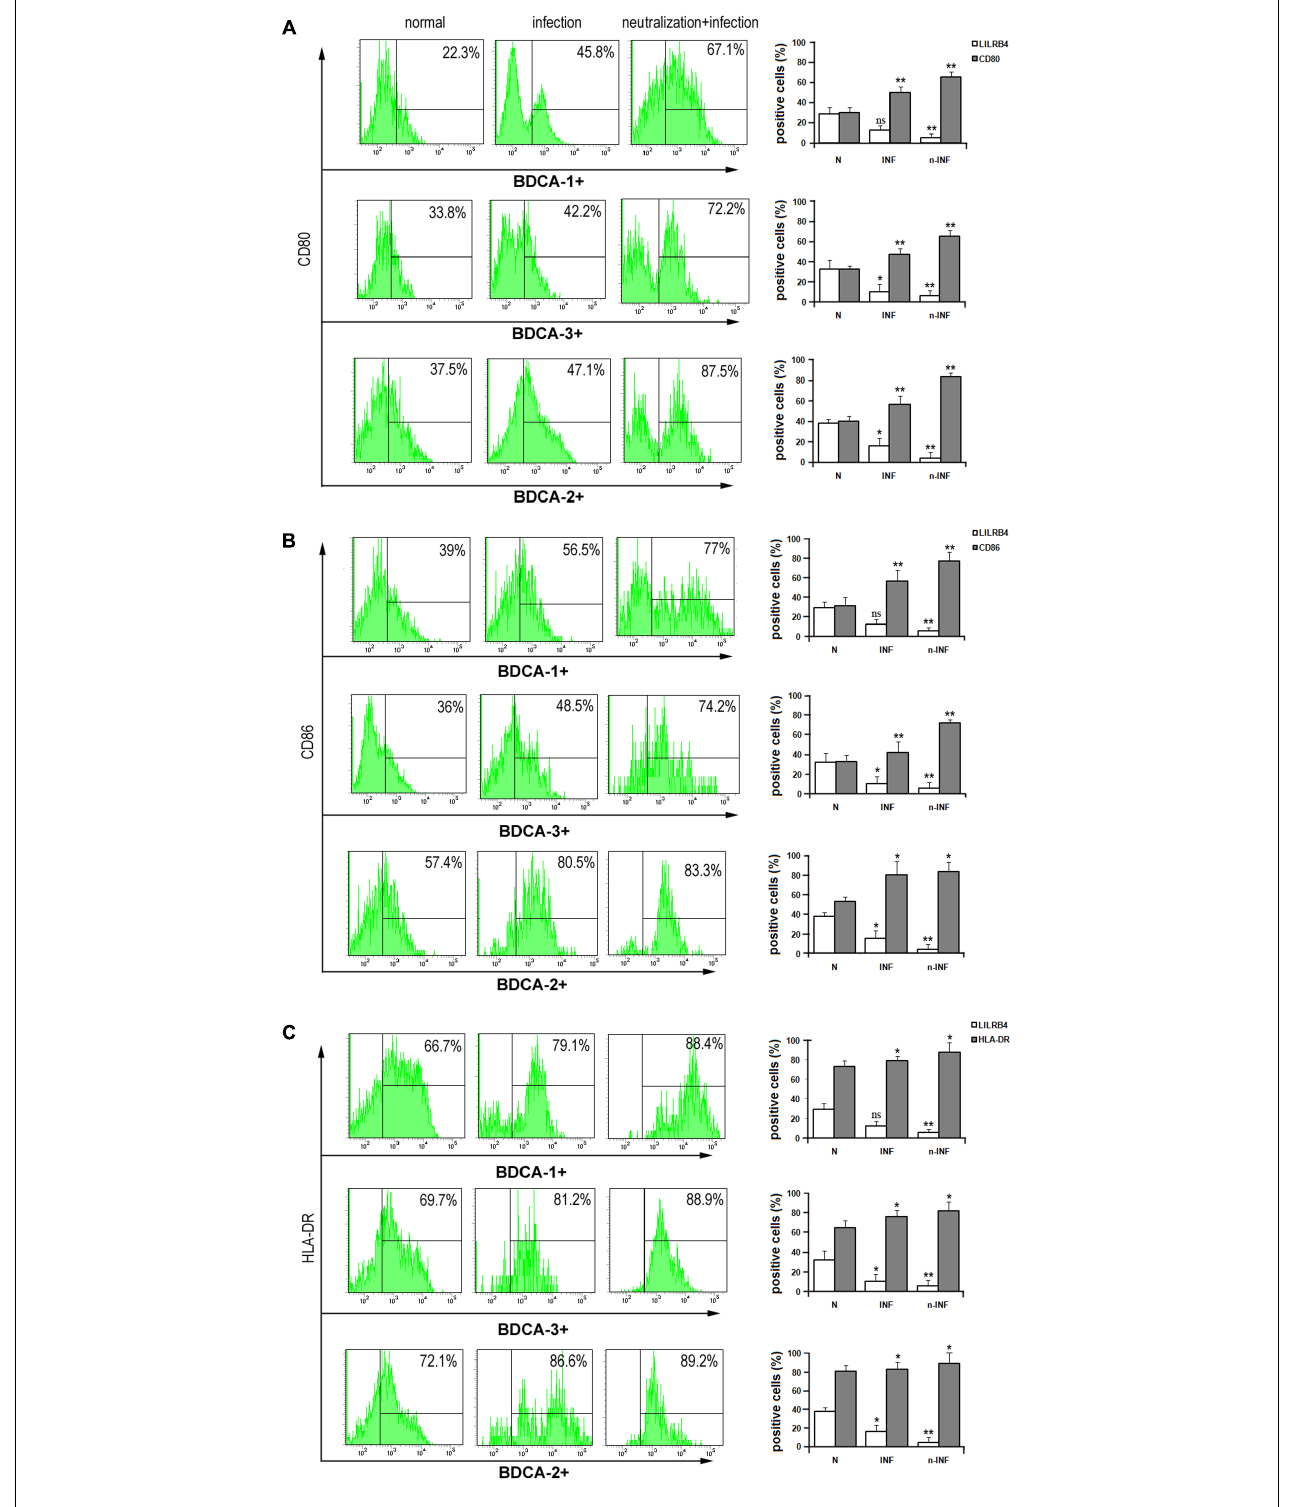
FIGURE 4 | Down-regulation of LILRB4 on human uDC subsets with T. gondii infection resulted in changes in the expression of functional molecules of human uDCs. Flow cytometry and histogram analyses of CD80 (A) , CD86 (B) , HLA-DR (C) and LILRB4 expression in BDCA-1 + , BDCA-2 + , and BDCA-3 + uDC subsets were performed for normal, infected, and anti-LILRB4 neutralizing antibody-treated infected human uDCs. Data are shown as means ± SD ( ∗ p < 0.05, ∗∗ p < 0.01). Representative data from six independent experiments for each group.